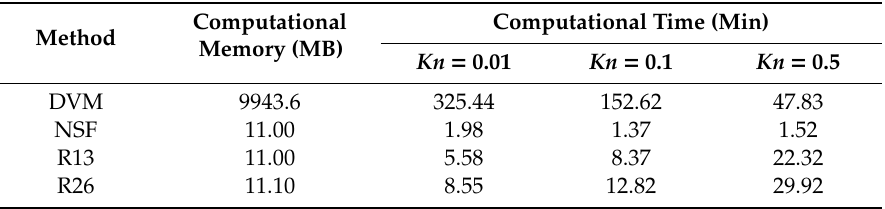
Table 2. Comparison of the computational cost between the DVM and moment method.